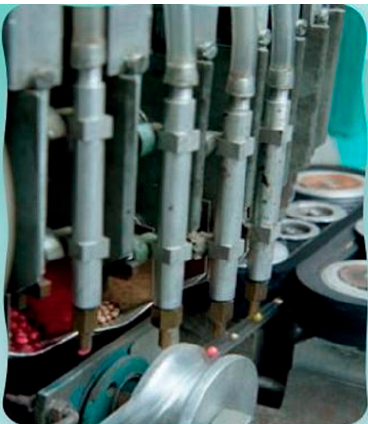
Figure 5. Air suction seed metering device (https://www.sedos.sk/Data/1049/UserFiles/SEDOS%20Catalogue%202012%20ENG.pdf (accessed on 8 October 2021)).